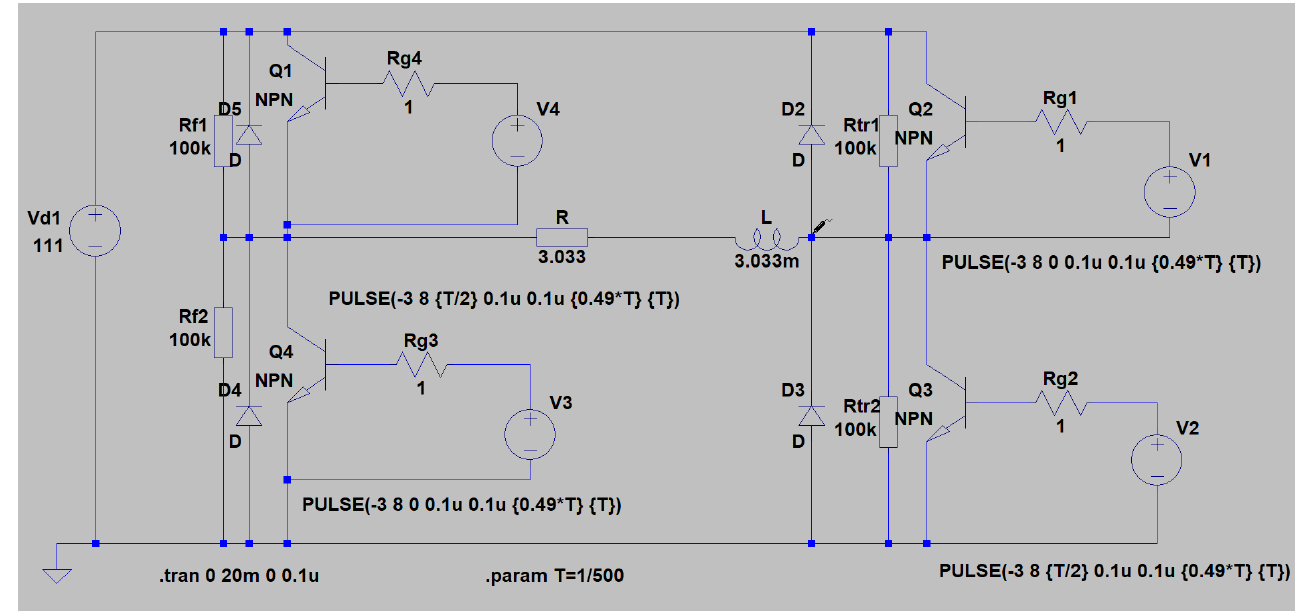
Figure A4. Simulation model of a voltage source inverter.